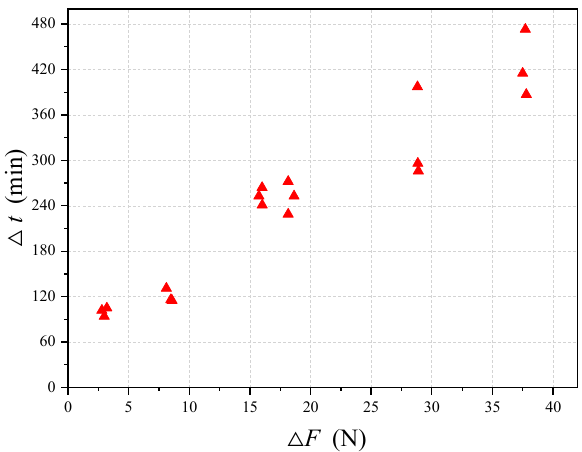
Figure 10. Relationship between ∆ t and ∆ F obtained from 18 corrosion tests.